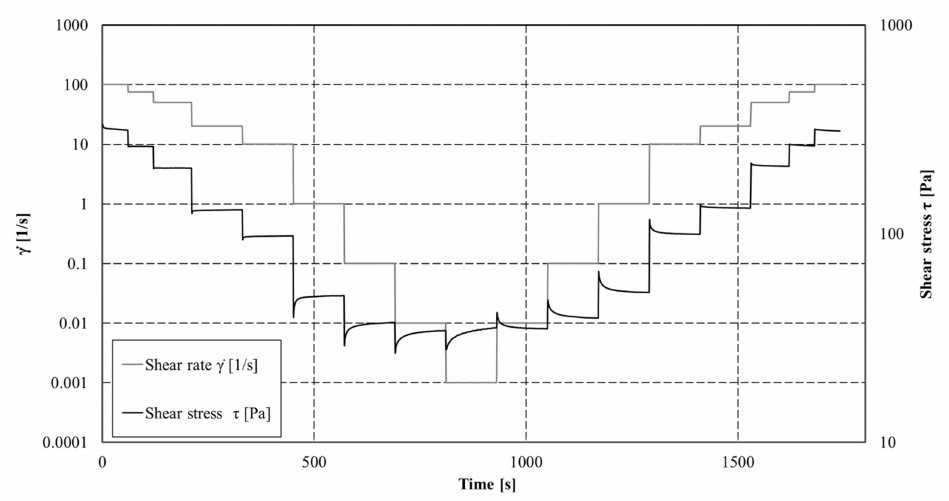
Figure 2. Shear rate applied and shear stress measured as function of time (example on a cement paste with 225 g of PCMs).